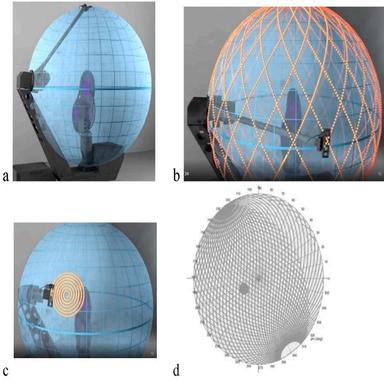
The scan path of SGP: a) the assumed sphere the detector moves around, b) A continuous movement path of the detector around the sample to capture all directions, c) a detailed spiral or square scan of a peak region (high-resolution scanning), d) resultant scan pattern (refined peak scanning was performed in position θ =25◦ φ=210◦).